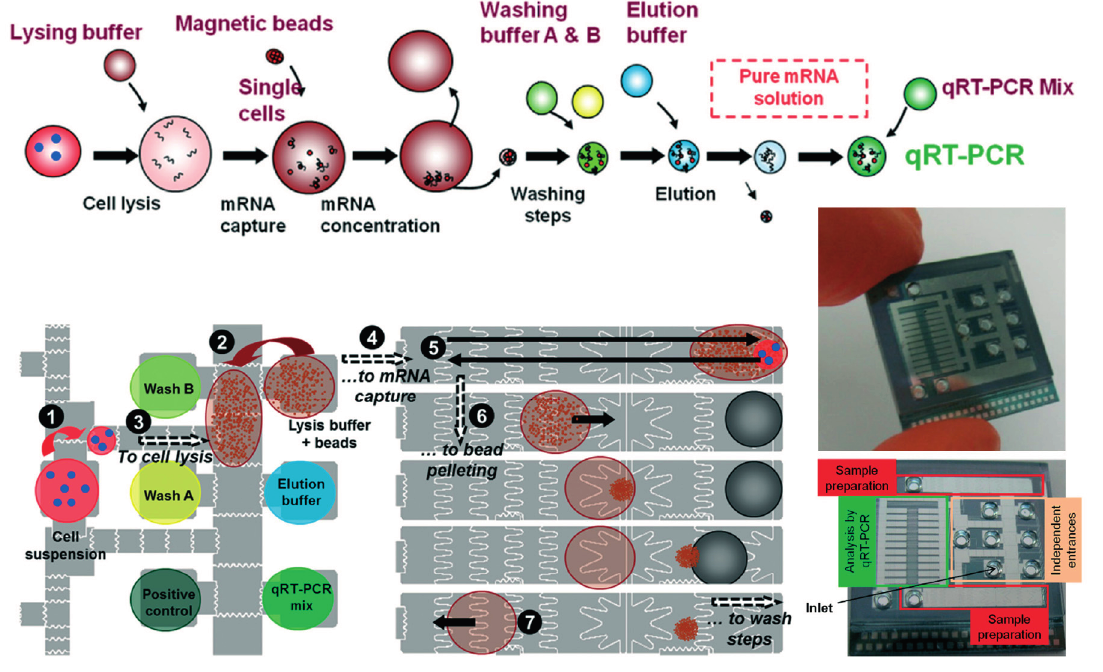
Figure 4. An integrated EWOD system for genetic analysis based on a single cell described by Rival et al. , 2014 [16]. The lysis and mRNA capture steps: (1) A droplet containing a few cells is dispensed; (2) A droplet of lysis buffer and magnetic beads is dispensed; (3) A droplet with the cells and a droplet with the beads are merged for cell lysis; (4) This merged droplet is moved to the “sample preparation” electrodes for operating magnetic beads; (5) The droplet is moved back and forth to enable bead mixing and mRNA capture; (6) The droplet is moved towards the magnet, the beads are concentrated to result in bead extraction; (7) An empty droplet is moved towards the waist. Reproduction of the figures has been made with permission from The Royal Society of